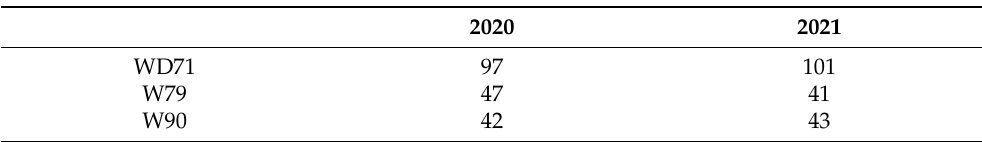
Table 1. Current citation counts per year for three major publications related to the Wilson–Devinney model (last two years,